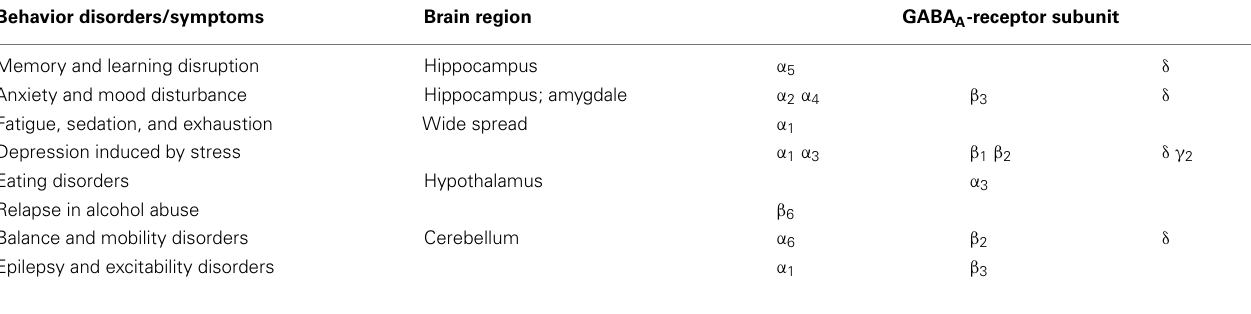
Table 2 | Relationship between behavior disorders/symptoms, brain areas, and subunits of the GABA A -receptor. Behavior